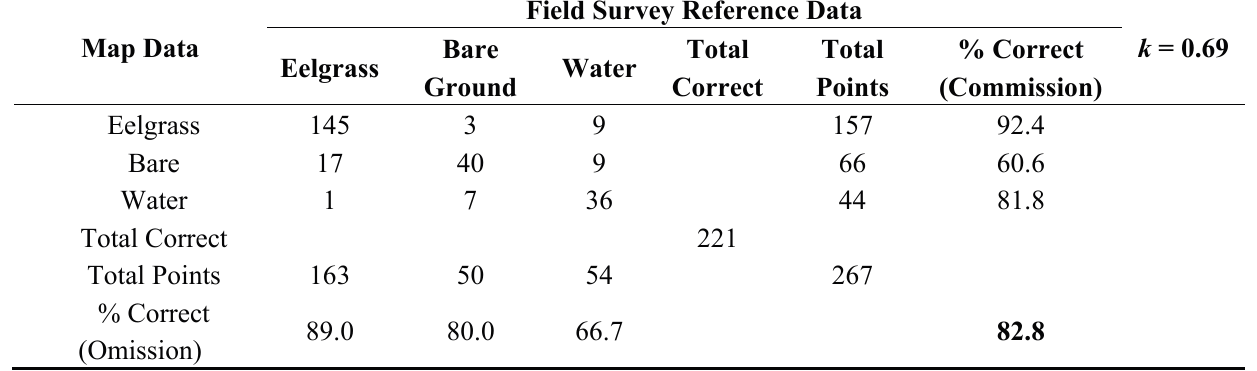
Table A1. Initial classification of habitats in Izembek